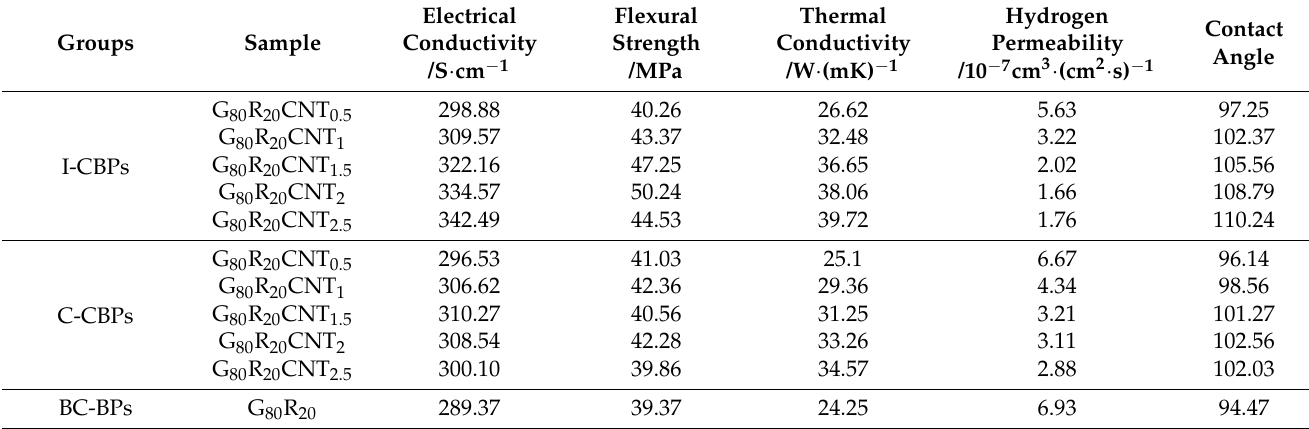
Figure 8. Surface morphology of composite bipolar plate: ( A ) BC-BPs; ( B ) I-CBPs; ( C ) C-CBPs; FESEM diagram of composite bipolar plate cross-section: ( D ) BC-BPs; ( E ) I-CBPs; ( F ) C-CBPs; ( G ) In situ deposited MWCNTs formed a network-like structure; ( H ) in situ deposited MWCNTs filled the pores of EG; ( I ) excess in situ deposited MWCNTs agglomerated inside BPs; ( J , K ) agglomerated MWCNTs particles inside C-CBPs; ( L ) surface morphology of BPs with crack. Table 3. Performance of composite